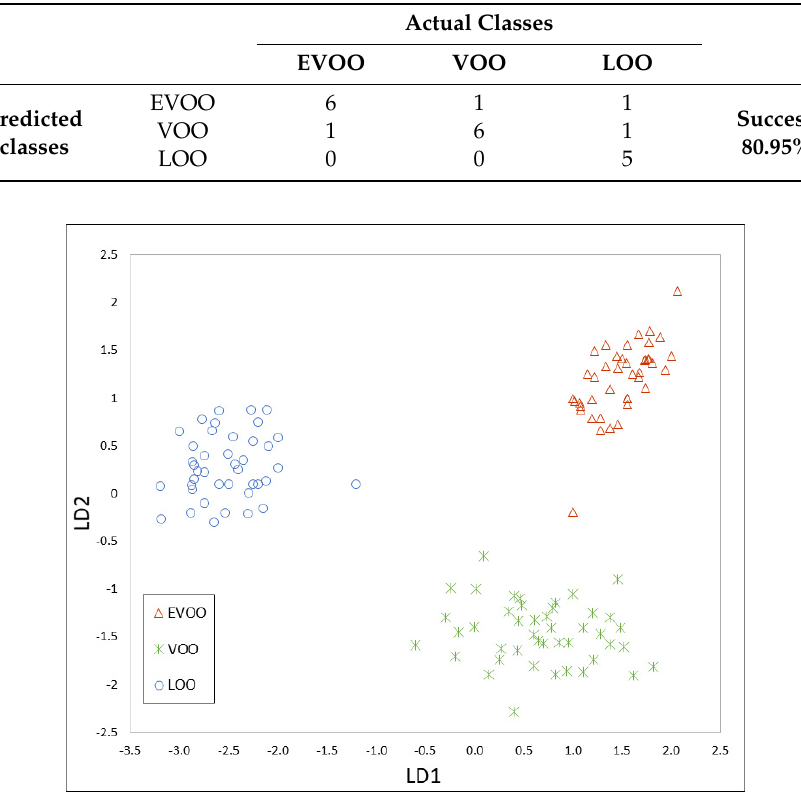
Figure 6. PCA-LDA model constructed using data fusion.